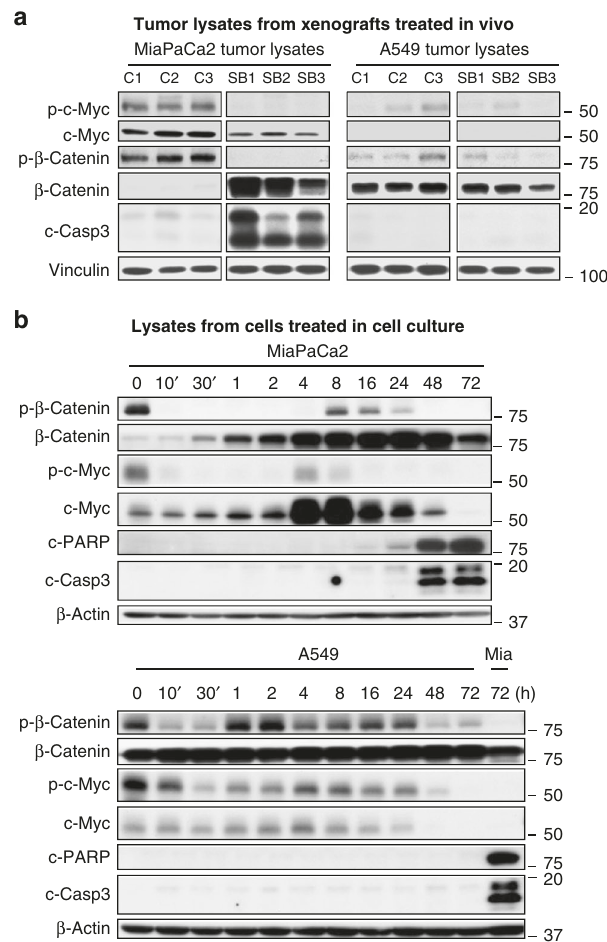
Fig. 4 SB blocks the phosphorylation of β -catenin S33/S37/T41 and T58 c-Myc. a Western blots of MiaPaCa2 and A549 tumor lysates from xenografts resected from mice treated with vehicle or SB. C1, C2, and C3 are tumors from mice treated with vehicle control. SB1, SB2, and SB3 are tumors from mice treated with SB. Experiment was done once. b Western blot of MiaPaCa2 and A549 cells treated with 1 µ M SB for various lengths of time. Mia designates MiaPaCa2 lysates used as positive